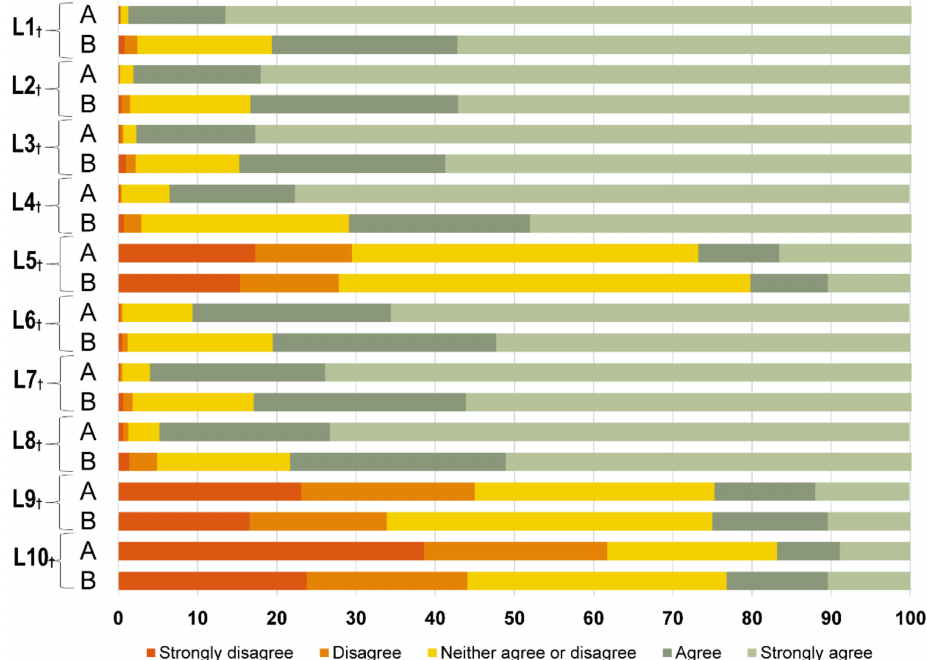
Figure 2. Distribution of parental responses to the 10 items on the vaccine-hesitancy scale. † p < 0.05. A = category A vaccine; B = category B